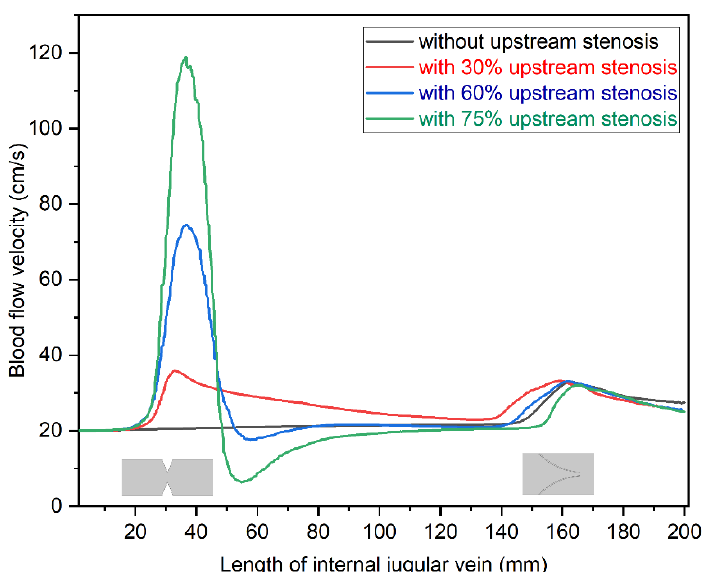
Figure 8. Comparison of maximum velocity (20 cm/s) profiles against the length of the modeled internal jugular vein, recorded at t = 3 s. internal jugular vein, recorded at t = 3